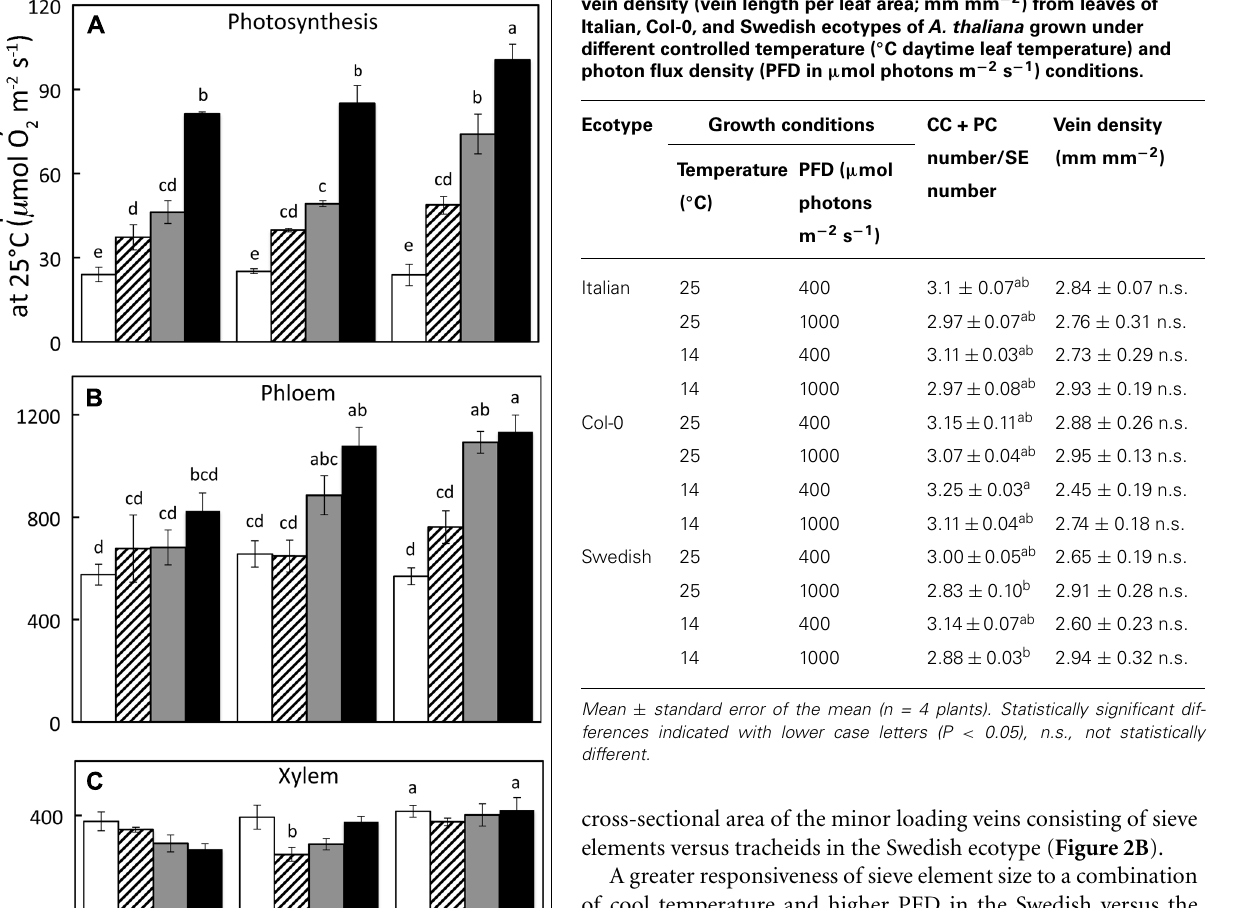
Table 1 | Companion and phloem parenchyma cell (CC + PC) number per associated sieve element (SE) number in minor loading veins